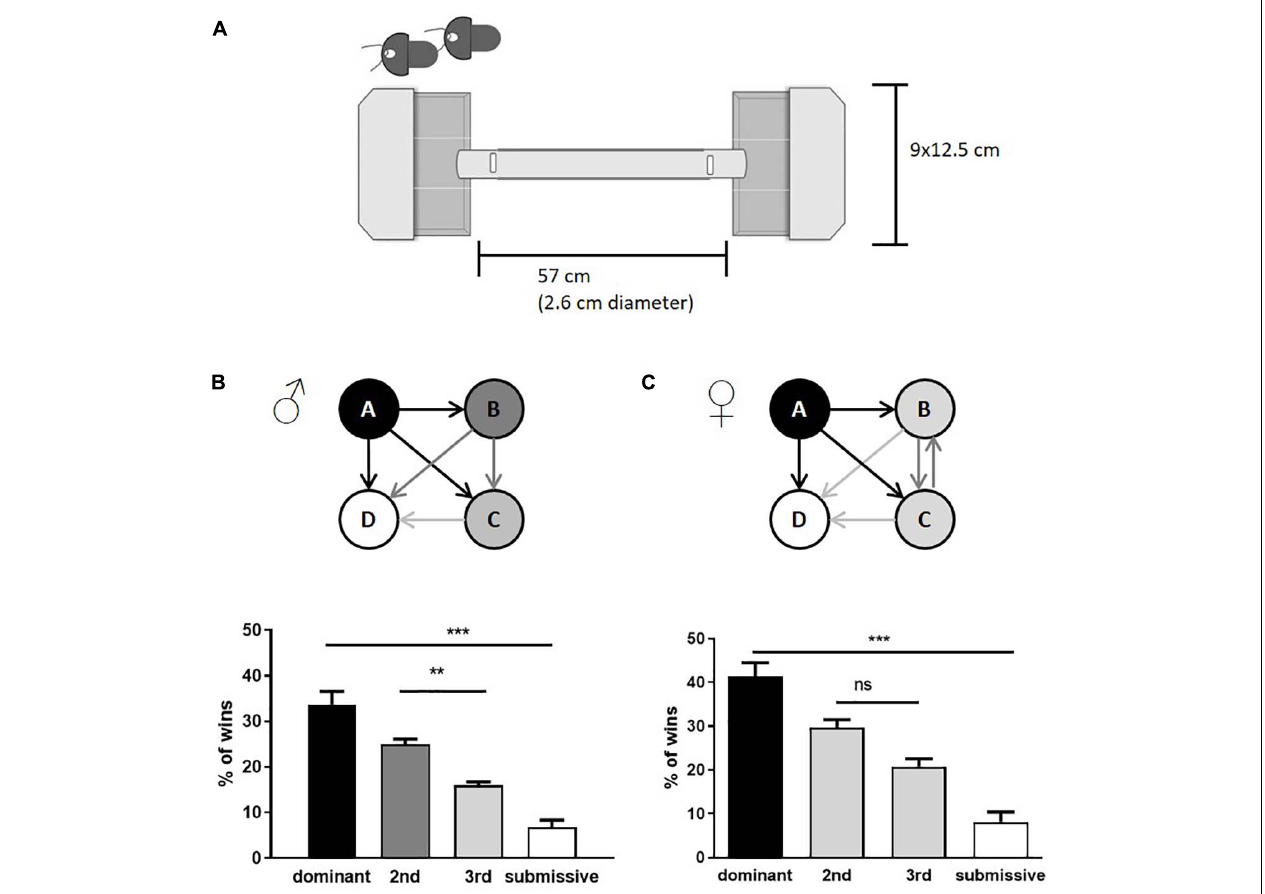
FIGURE 1 | Assessment of social hierarchy in group-housed male and female mice. Schematic representation of tube test equipment is shown in (A) . The test consisted of two non-transparent boxes with lids where the mice were placed. At the same time, access to the tube was denied by inserted shutters (indicated in the upper left corner, the shutter position within the closed setup as labelled by vertical white rectangles). The boxes were subdivided with transparent plastic sheets, limiting the freedom of movement, and motivating the mice to enter the tube. Both shutters were removed simultaneously, and the confrontation of mice was observed within the transparent tube. Cage hierarchies were identified by the number of test runs considered as “win” per mouse (male: B ; female: C ). Arrows indicate the mean of relations within the cage groups; the number of wins in % of dominant and submissive animals is given as mean + SEM. Statistical analysis was performed with a one-way ANOVA with Bonferroni’s post-hoc comparison test [ n = 28 mice per sex in total were tested, in each category (e.g., “dominant”) all test values from the seven mice belonging to this category are integrated; ** p < 0.01, *** p < 0.001; ns, p >